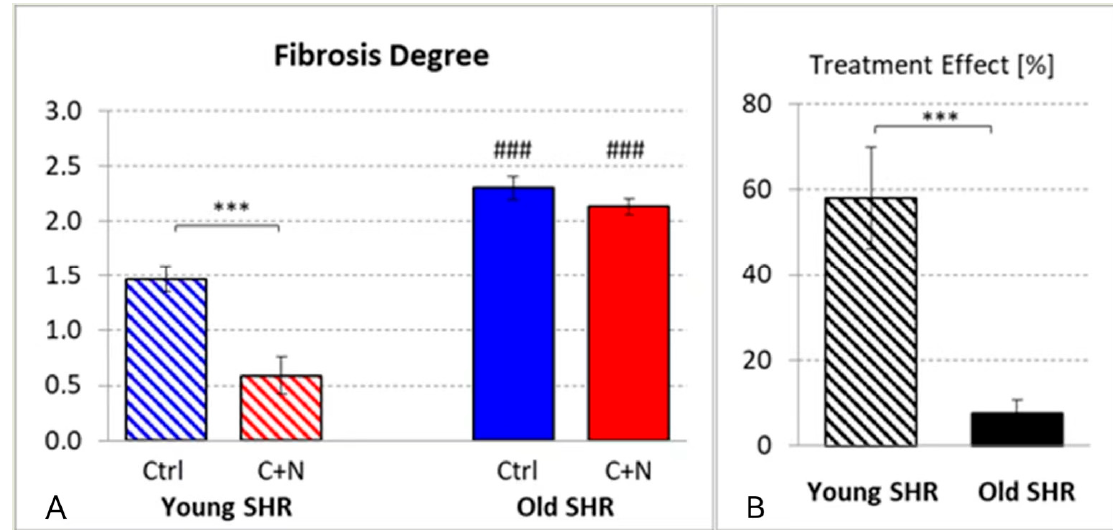
Figure 5. ( A ) Degree of fibrosis in untreated (Ctrl) and treated (C+N) young and old SHRs. ( B ) Treat- ment effects in young and old SHRs (in % of corresponding average Ctrl value). Significance marks: (cid:100) * (cid:101) significant difference between marked groups, *** p < 0.001; ### significant difference to corre- sponding young SHR group, p <